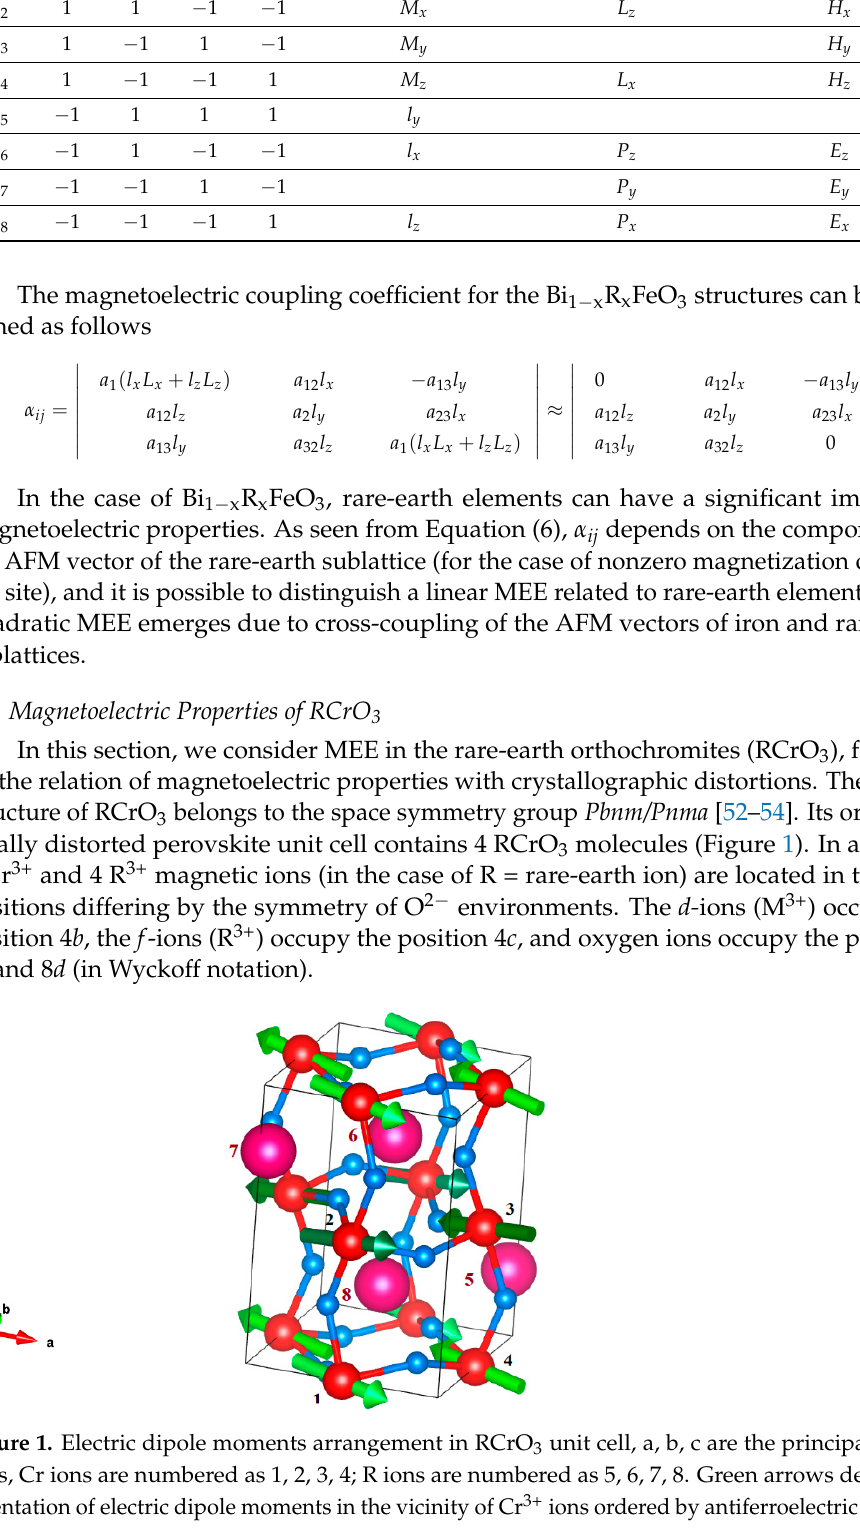
Table 2. Irreducible representations of the Pnma symmetry group.